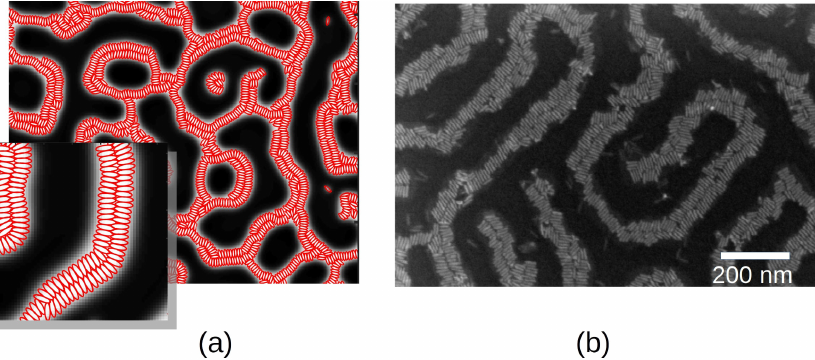
Figure 15. Moderate filling fraction of anisotropic NPs in BCP mixture. Comparison between ( a ) simulations with inset and ( b ) SEM image showing 33 nm-long CdSe NRs coassembled with PS- b -PMMA with H 0 = 132 nm periodicity (PS domain size is L 0 = 75 nm). The experimental NR diameter is 4.6 nm with a filling fraction of 0.26. Reprinted with permission from Ref. [115].